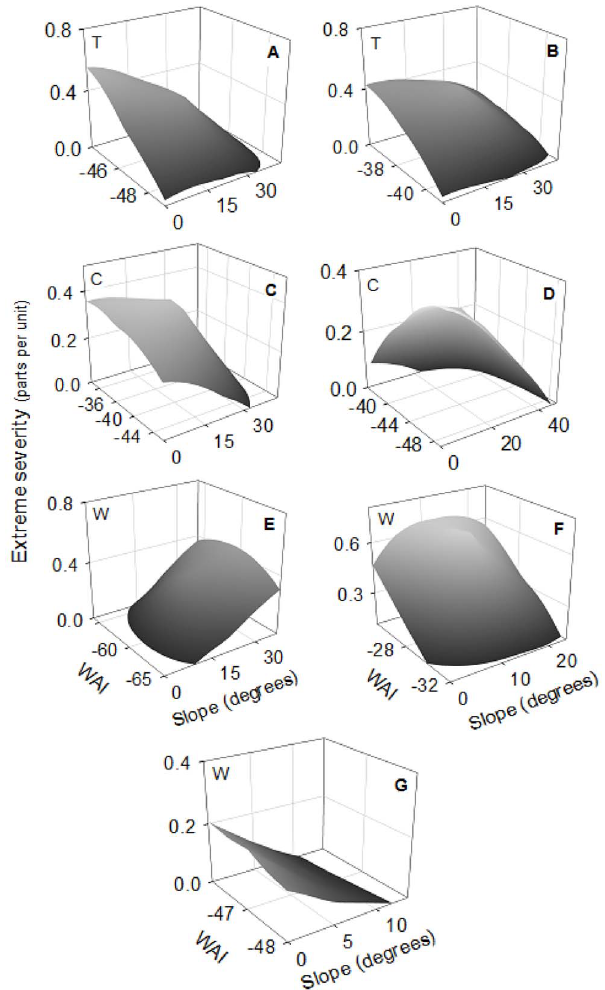
Figure 5. Significant interactions of Slope ( 6 ) and WAI on extreme fire severity (parts per unit). Letters in the top-right corner indicate the fire: (A) Castellbell i el Vilar 2003; (B) Castellbisbal 2005; (C) Cardona 2005; (D) Castellnou de Bages 2005; (E) Riba-roja d’Ebre 2005; (F) Ventallo´ 2006; (G) Mont-roig del Camp 2007. Letters in the top-left corner indicate the fire type: (T) topographic fires; (C) convective fires; (W) wind-driven fires.